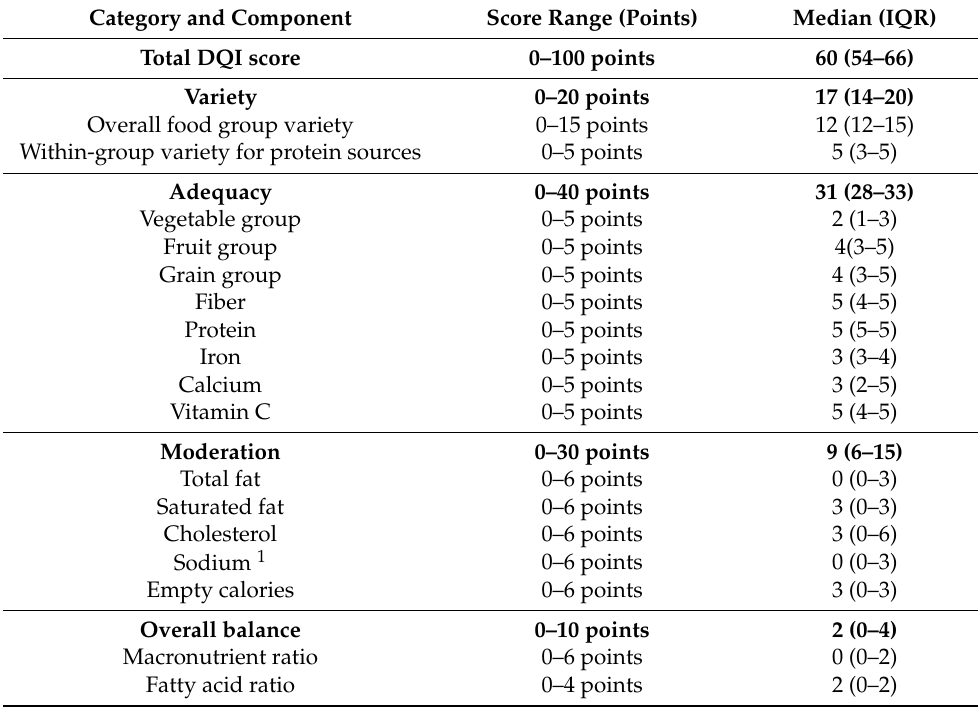
Table 3. Median (IQR) scores for DQI-I components ( n =